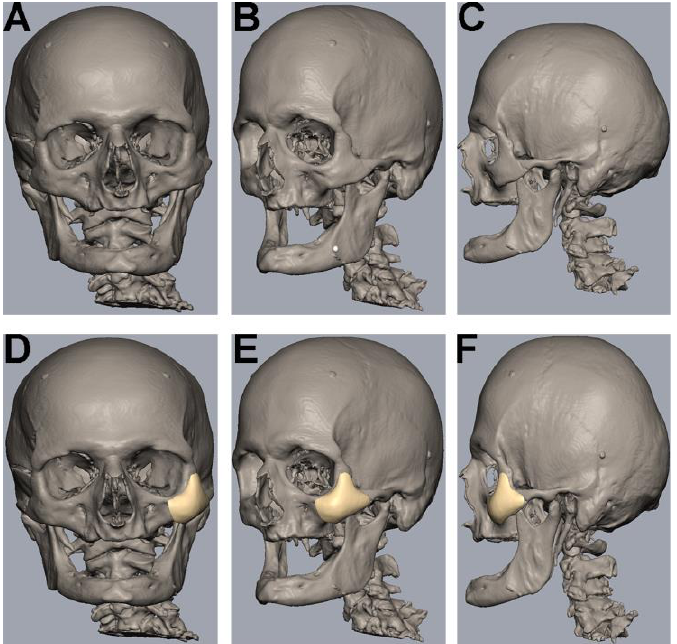
Figure 1. Segmentation, 3D-reconstruction and virtual planning of the zygomatic implant